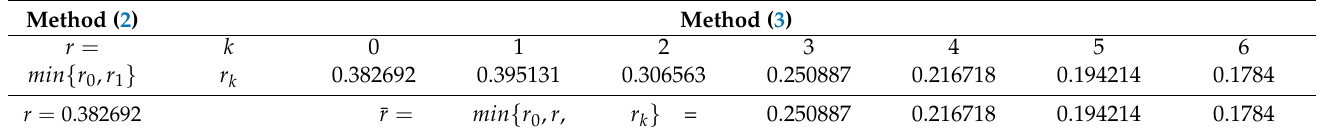
Table 1. Estimates for Example 1.